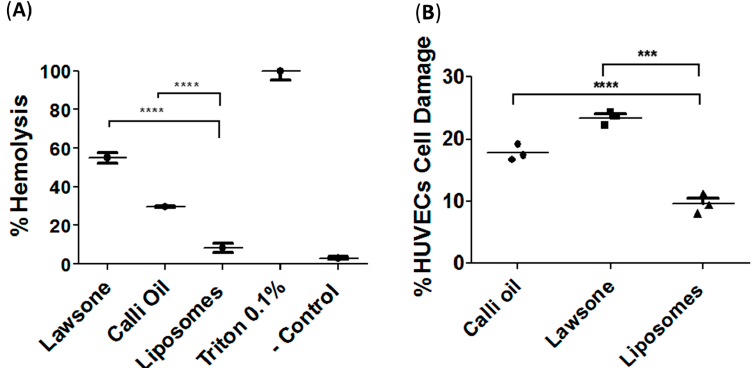
Figure 7. Cytotoxicity assays of prepared liposomes compared to Calli oil or lawsone alone using either ( A ) RBCs hemolysis assay or ( B ) HUVEC injury assay. The data display the mean of the percentage of hemolysis or percentage of cell damage ± standard error of the mean. The statistical significance was calculated with one-way ANOVA and significance level indicated by asterisks (*** p = 0.0005, and **** p =